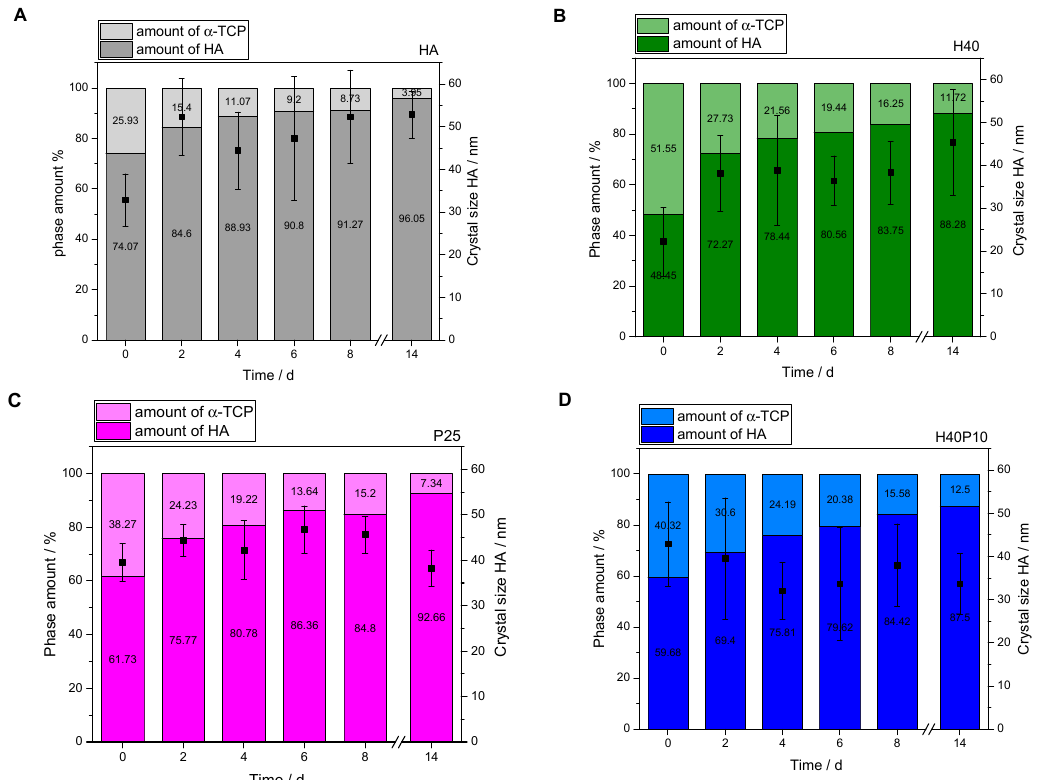
Figure 8. Overview of Rietveld refinement with analysis of HA crystal size. ( A ) Inorganic reference HA; ( B ) HA with polymeric addition of 40 wt% HEMA (H40) in liquid phase; ( C ) HA with polymeric addition of 25 wt% synthesized hydrogel precursor (P25) in liquid phase; ( D ) HA with combination of 40 wt% HEMA and 10 wt% cross-linker (H40P10) in liquid phase.